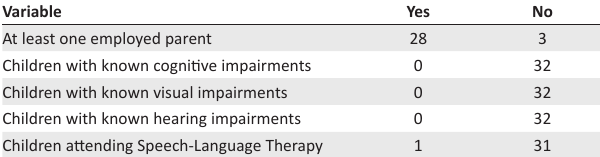
FIGURE 1: Reported first languages of TABLE 2: Children’s reported background information.